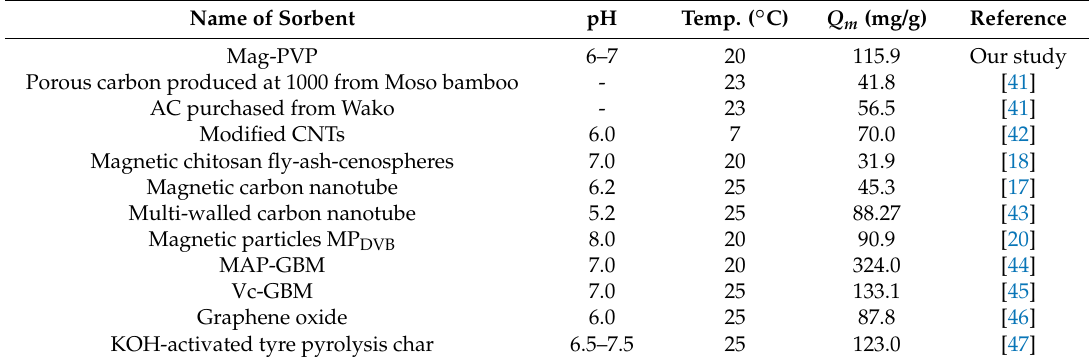
Table 3. Comparison of BPA adsorption on Mag-PVP with other